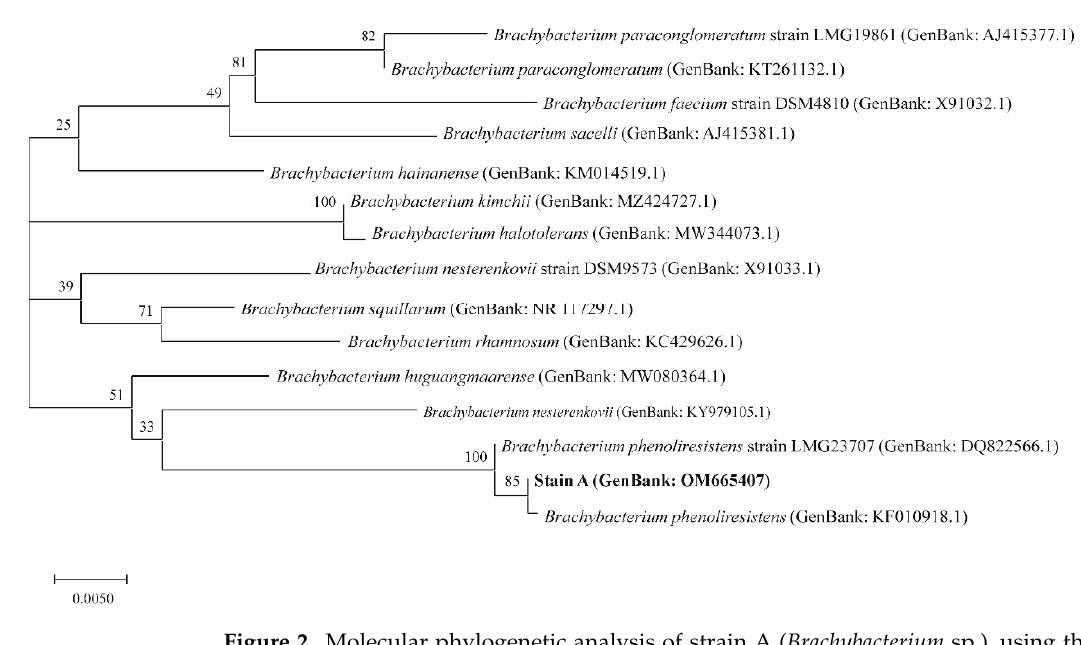
Figure 2. Molecular phylogenetic analysis of strain A ( Brachybacterium sp . ) using the maximum likelihood method.